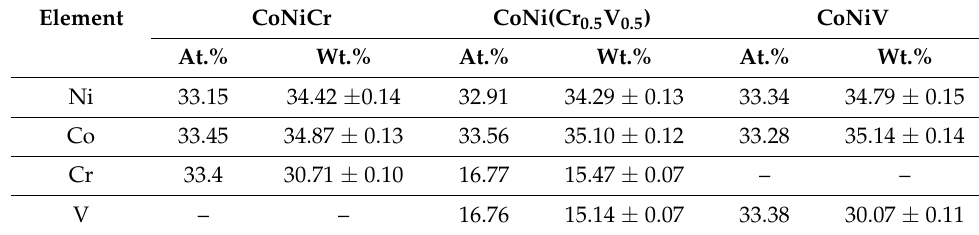
Figure 1. XRD graphs of the CoNiV, CoNiCr Table 1. Elemental composition of the samples in atomic and weight